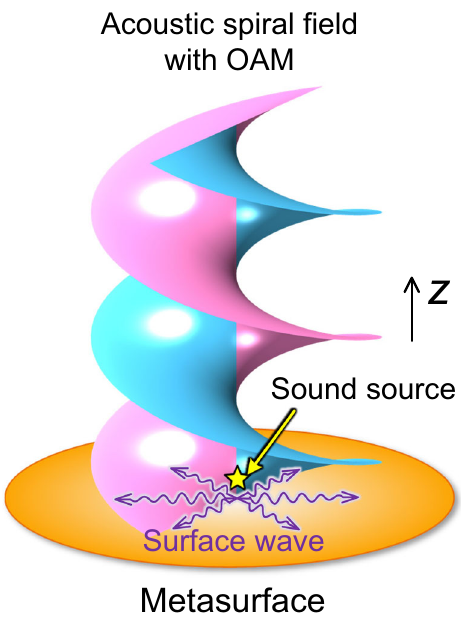
Fig. 1 Illustration of the metasurface antennas. The axisymmetric acoustic surface waves are launched by a monopolar sound source (yellow pentagram) located at the center of the metasurface antennas (orange plate), as illustrated by the purple wave packet representing the pressure fi eld amplitude. These surface waves carrying zero OAM are scattered into the desired far- fi eld wave beam with arti fi cial OAM, depicted by the vortex phase